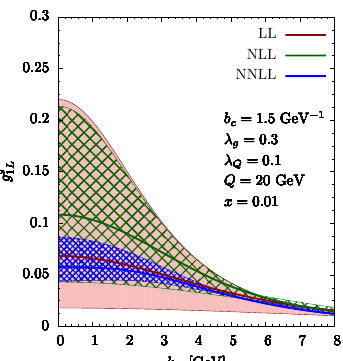
Figure 1 . The gluon helicity TMDPDF g g at Q = 20 GeV, x = 0 : 01 and with the non-perturbative 1 L parameters chosen to be (cid:21) g = 0 : 3 and (cid:21) Q = 0 : 1. The bands come from varying independently both the resummation scale (cid:22) 0 and the rapidity scale (cid:16) 0 by a factor of 2 around their default value, and taking the maximum variation.